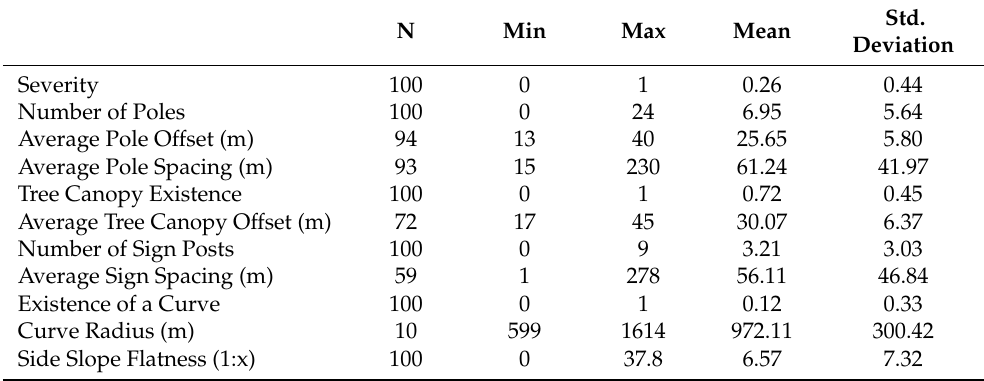
Table 2. Descriptive Statistics of